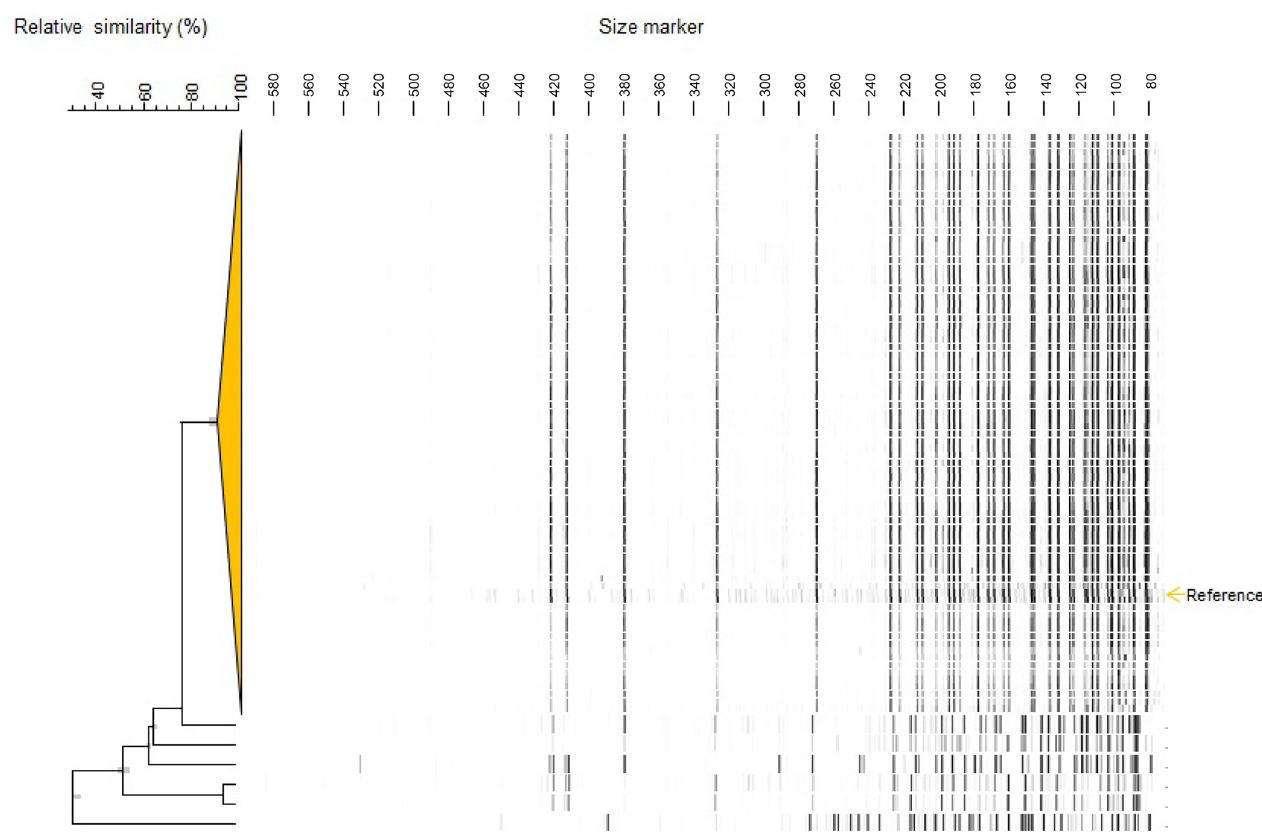
Fig 1. Dendrogram of C . difficile strains based on AFLP patterns of all ribotype 027 strains identified between May 2013 and March 2014. Hierarchical clustering of AFLP types was performed using unweighted pair-grouping. The cut-off value for identical strains was set at 90% relative similarity (BioNumerics, Applied Maths, Belgium). Besides 027 strains, a few other ribotypes that were found in the VUmc in the same period were included in the analysis, serving as an outgroup. All 027 strains included in this analysis were considered to be identical (large cluster on top).